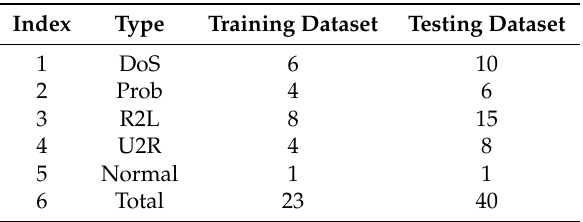
Table 4. Specific attack